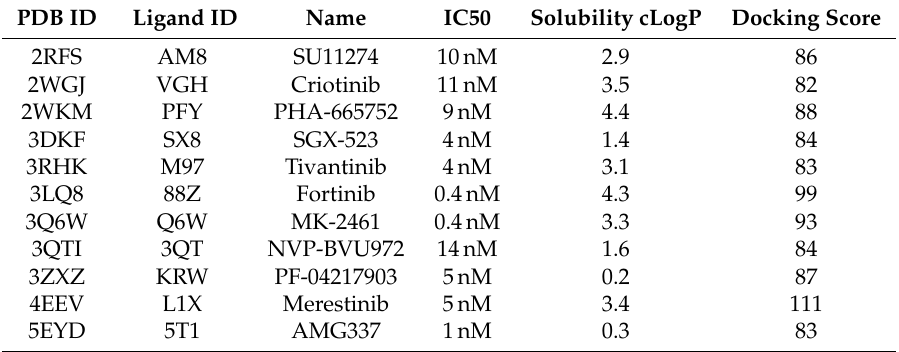
Table 7. Data used for some known marketed inhibitors with nano-molar range IC 50 found in the